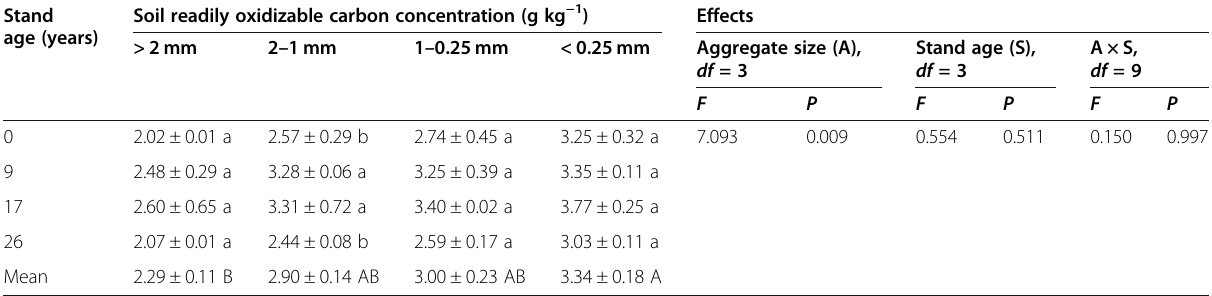
Table 4 Effects of aggregate sizes (> 2, 2 – 1, 1 – 0.25, and < 0.25 mm) and stand ages (0, 9, 17, and 26 years old) on the soil readily oxidizable carbon concentration in a chronosequence of Chinese fir plantations Stand Soil readily oxidizable carbon concentration (g kg − 1 ) age (years)